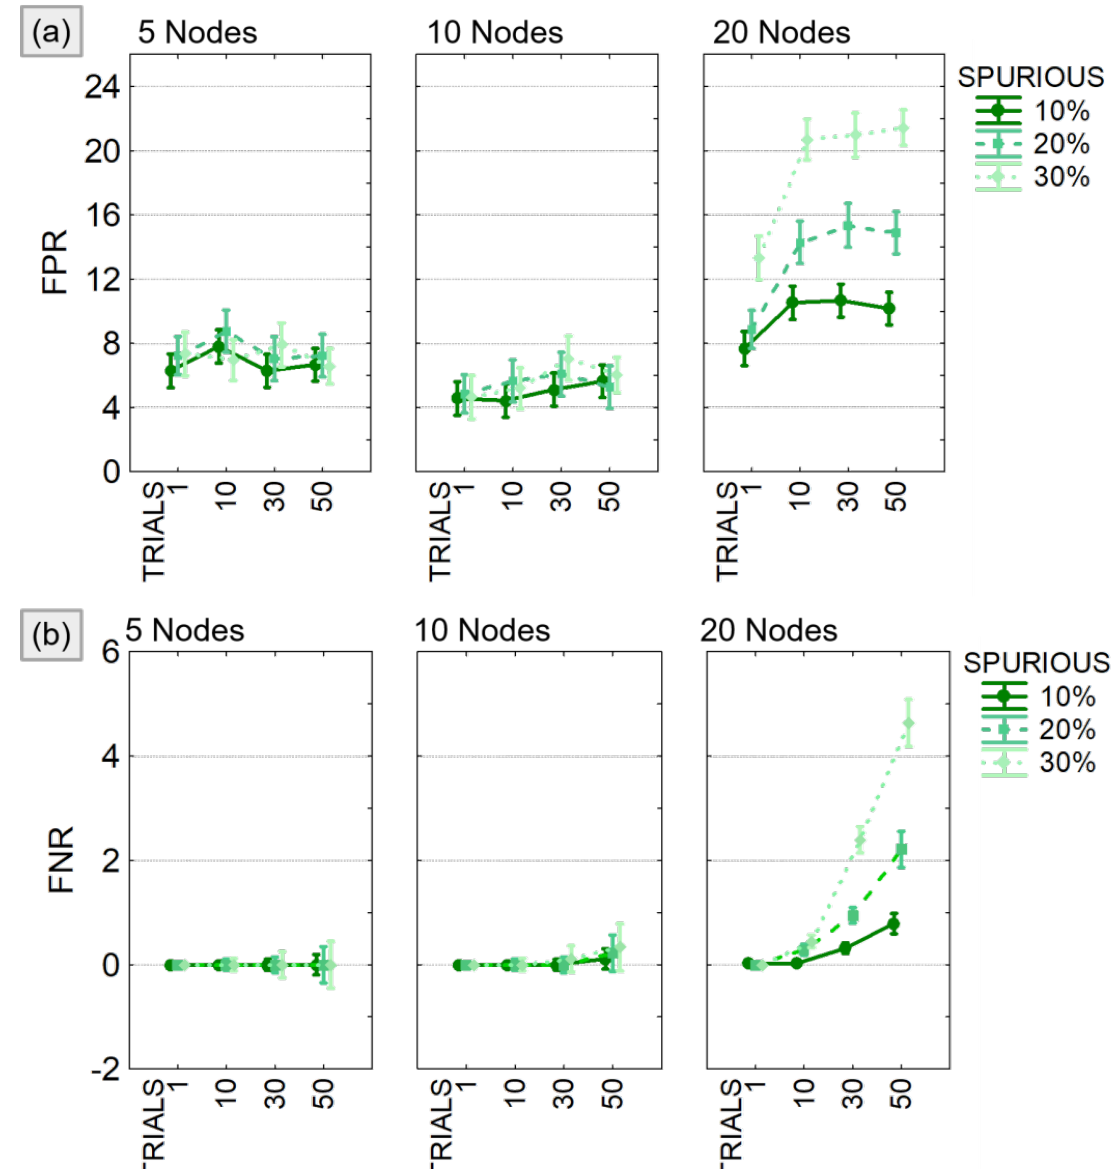
Figure 6. False positive and false negative in PDC estimates. Results of the three-way ANOVA performed to compare FPR (panel a ) and FNR (panel b ) in different experimental conditions defined by the number of existing spurious connections (SPURIOUS), the percentage of modified trials (TRIALS), and the dimension of the model (MOD_SIZE). The bars represent the 95% confidence interval.